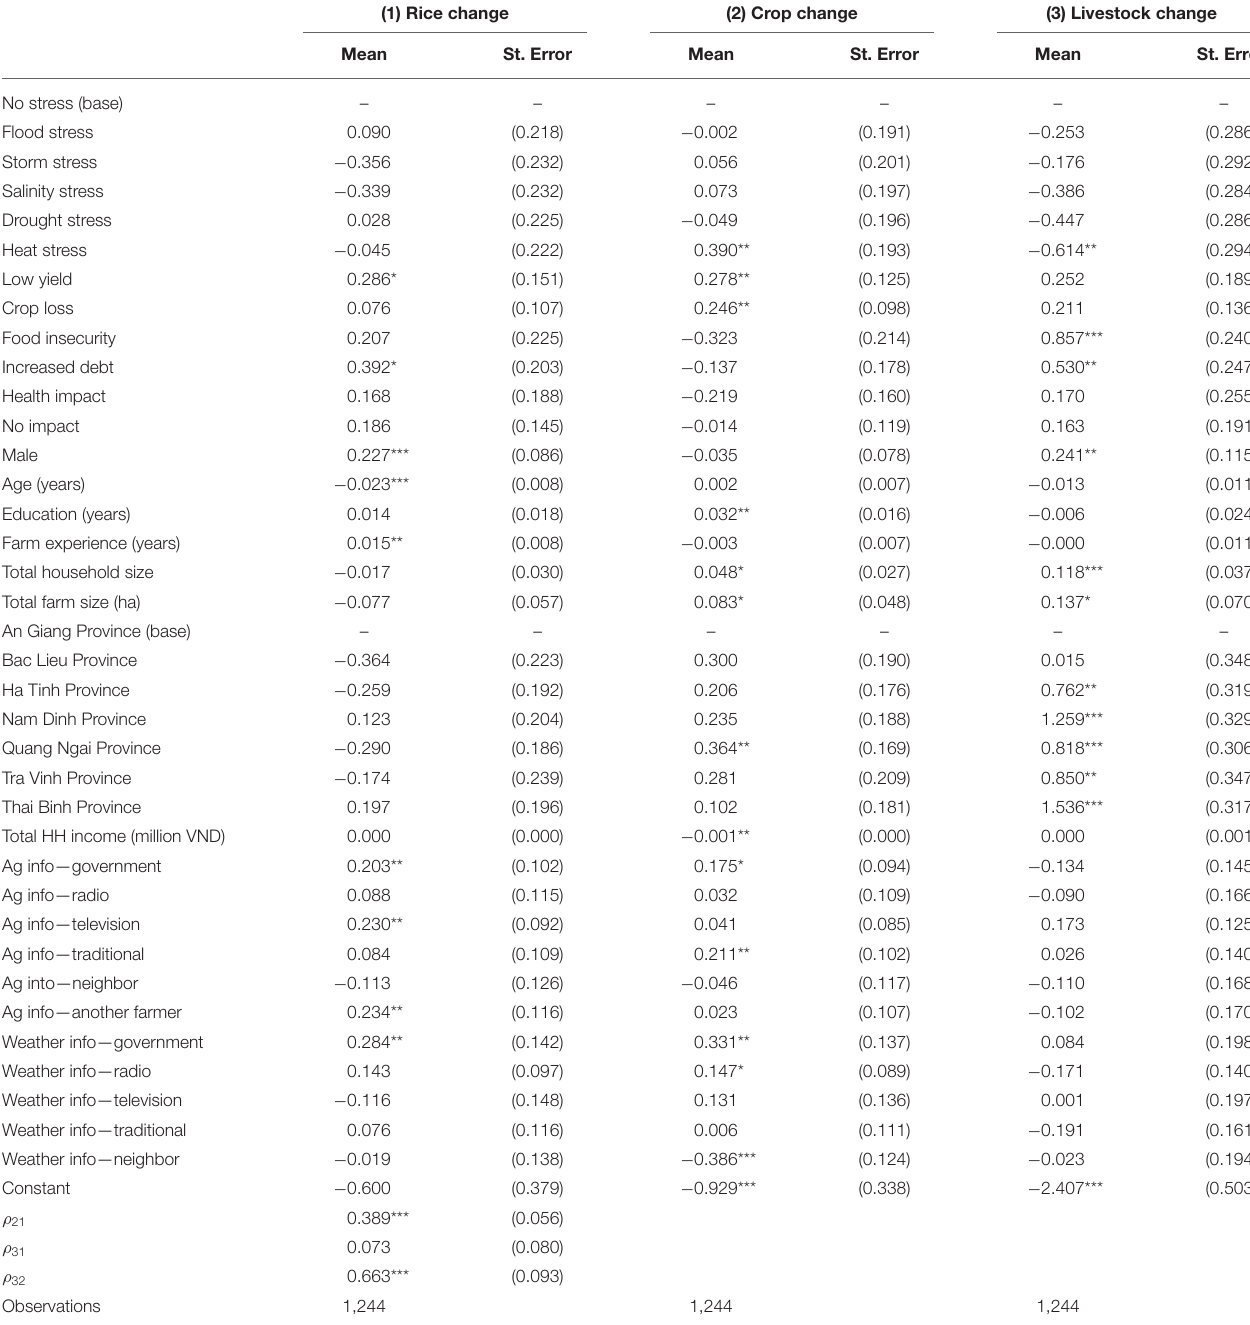
TABLE 3 | Multivariate probit results, agricultural adaptations to climate